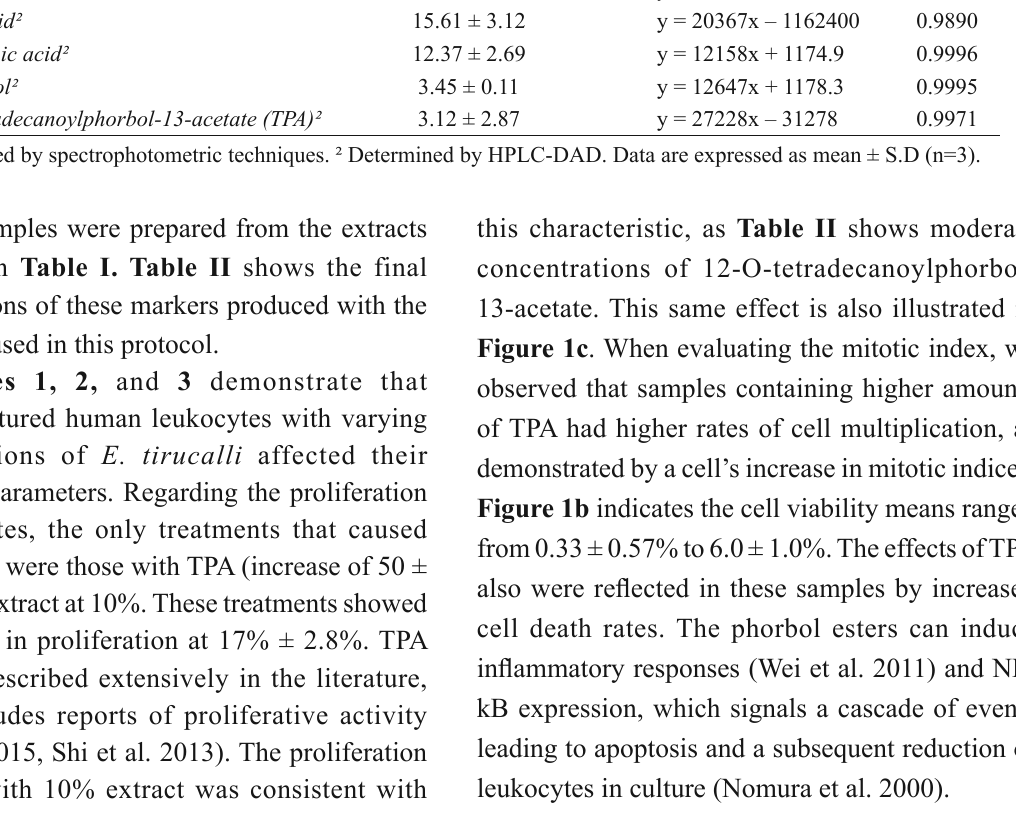
Concentrations of bioactive compounds identi fi ed in samples according to treatment. Concentrations of compounds in each treatment used in this protocol ( μ Compound